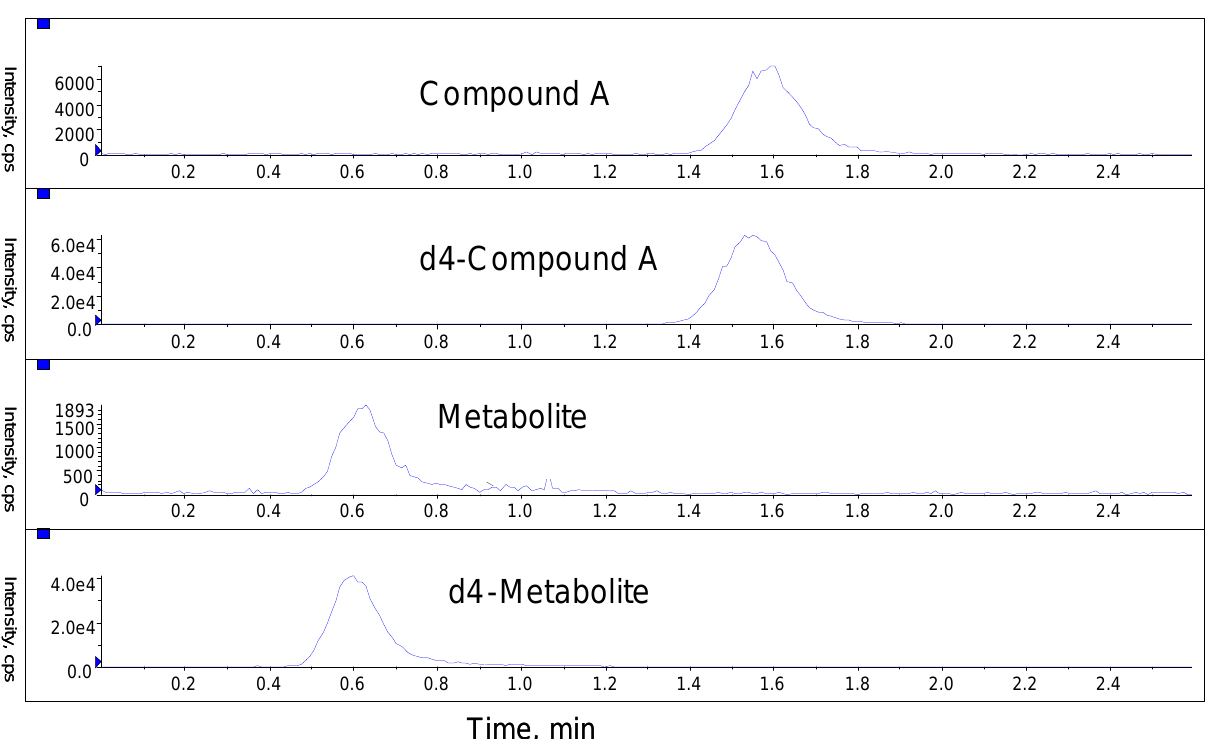
Figure 2. Representative ion chromatograms of an LLOQ sample from the dog whole blood